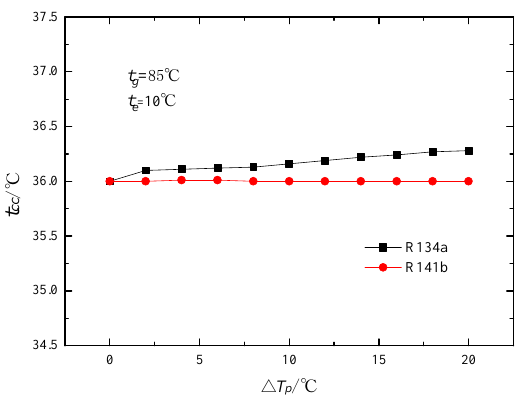
Figure 16. Critical condensing temperature versus the primary superheating (cid:52) T p .